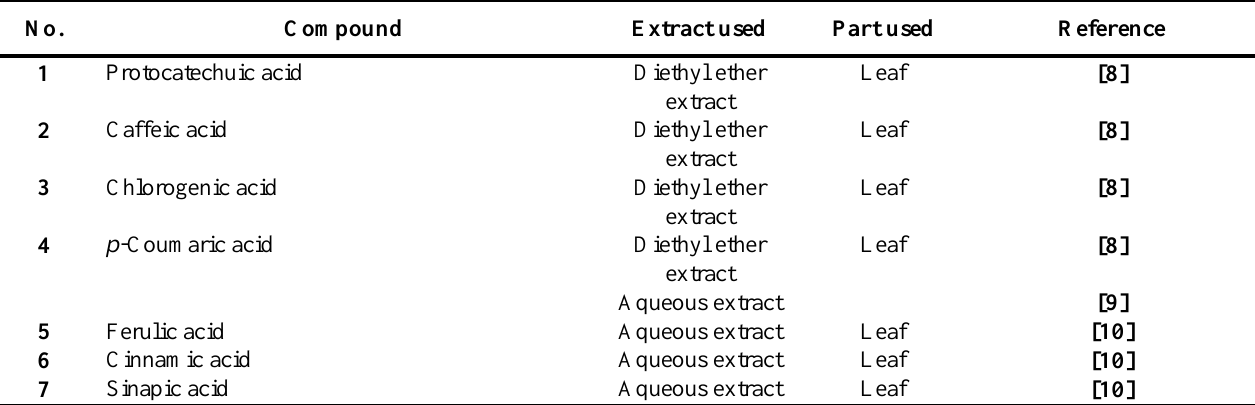
Table 1. Phenolic acids reported in C. papaya No.